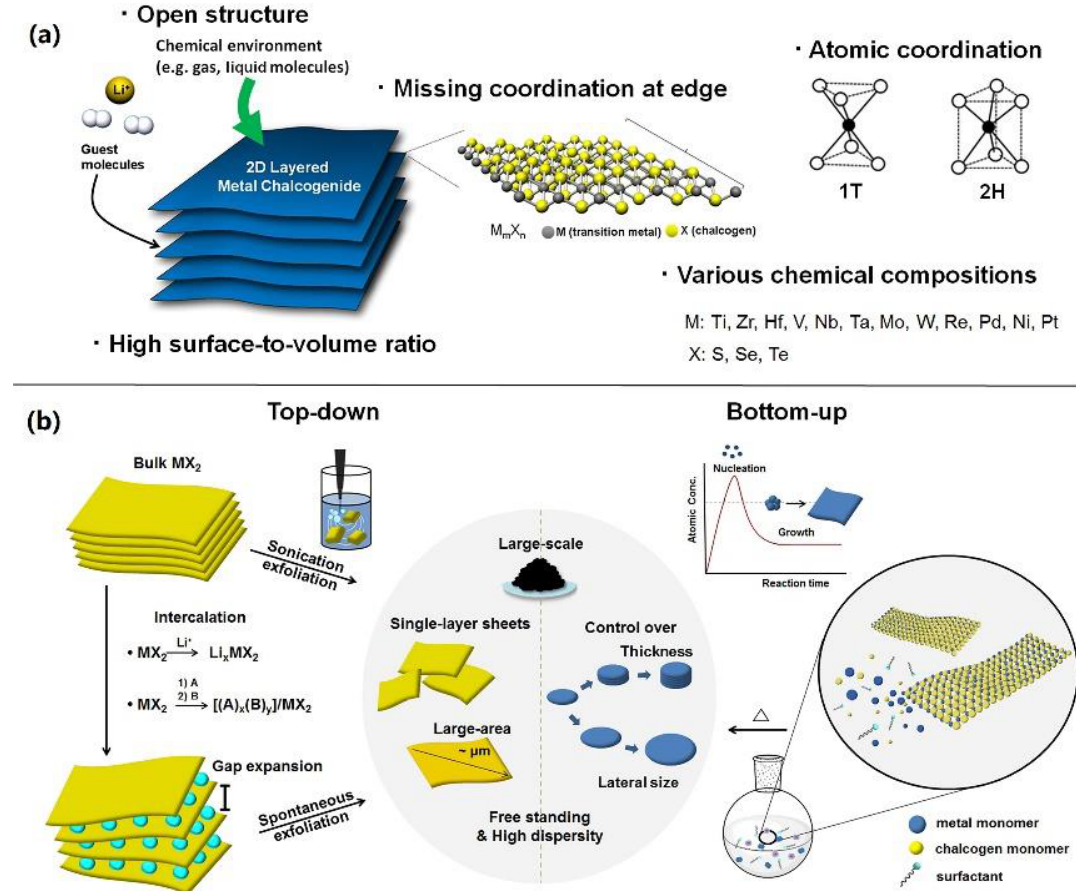
Figure 16. Structure ( a ) and solution-based preparation ( b ) of 2D layered transition metal chalcogenides (TMCs) nanosheets based on top-down and bottom-up approaches. Reprinted with (TMCs) nanosheets based on top-down and bottom-up approaches. Reprinted with permission permission from [36]. Copyright 2018, American Chemical Society. from [36]. Copyright 2018, American Chemical